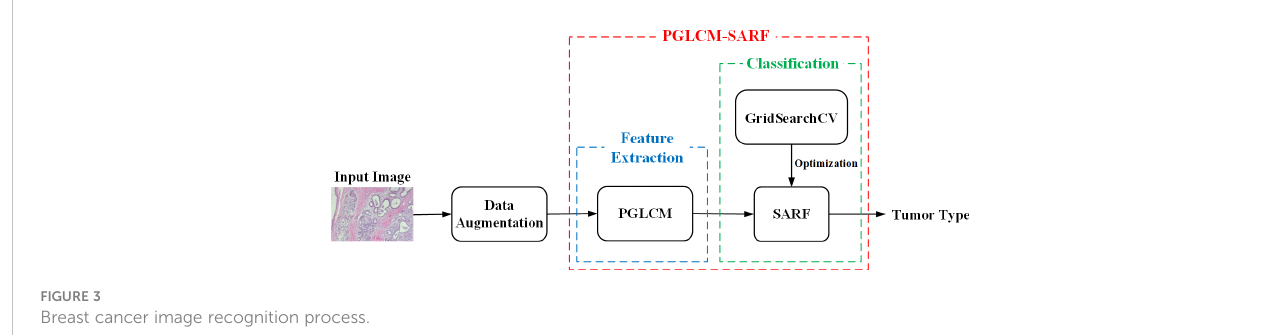
FIGURE 3 Breast cancer image recognition